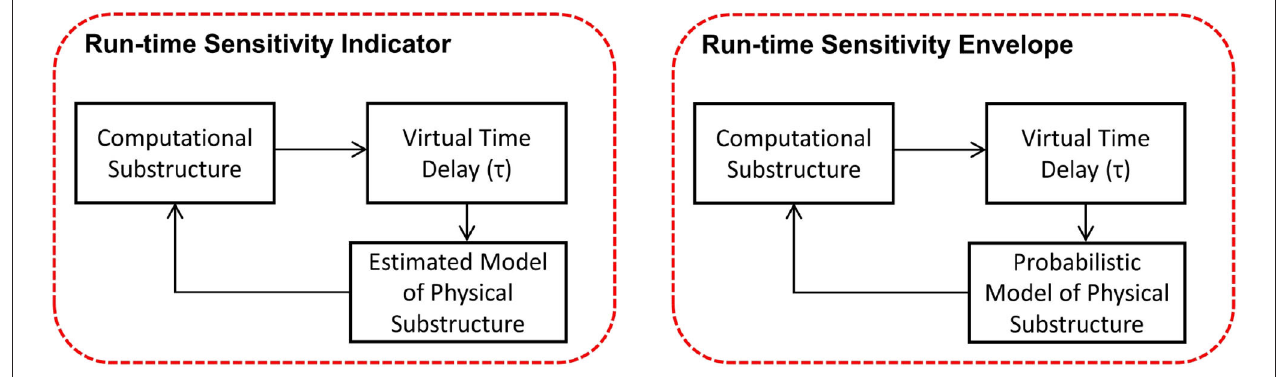
FIGURE 6 | Run-time sensitivity analysis: frameworks associated with run-time sensitivity indicator and run-time sensitivity